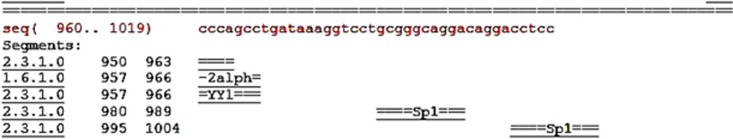
Transcription factor Sp1 is a potential binding protein of the hypomethylation region of APOC1P1. AliBaba 2.1 (http://www.gene-regulation.com/pub/programs/alibaba2/index.html) was used to predict the binding proteins. The promoter sequence and the binding segments of Sp1 are shown